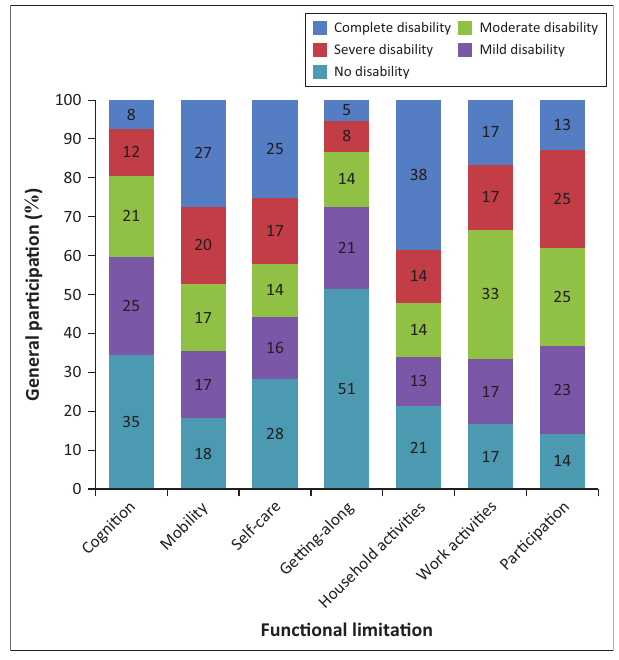
FIGURE 1: Extent of the patients’ functional